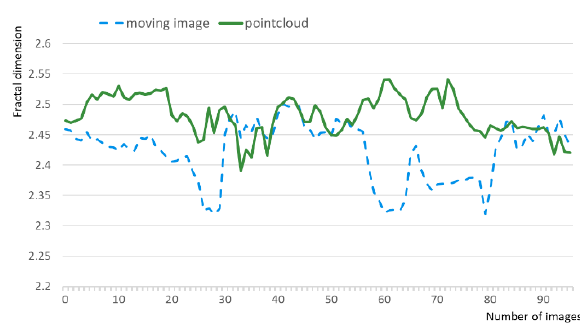
Figure 7 . The results of fractal analysis for both data.